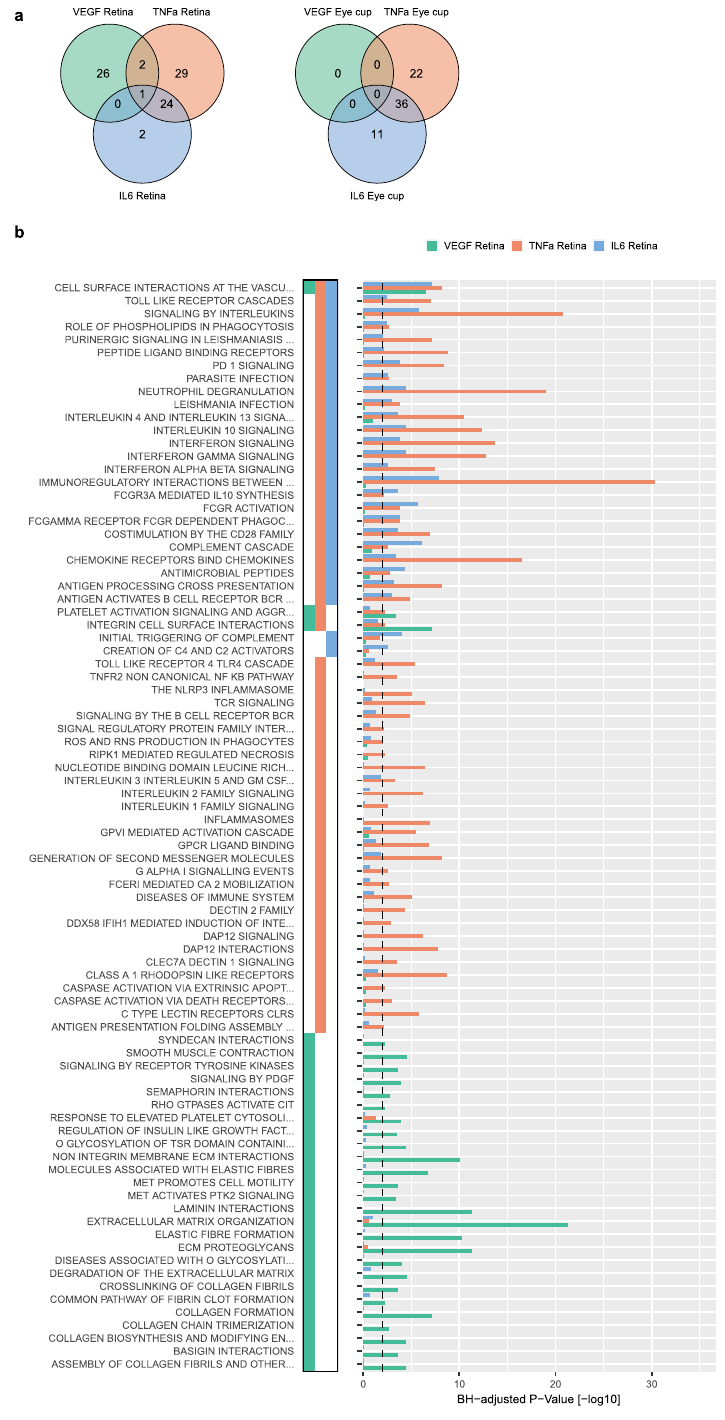
Figure 3. AAV-VEGF treatment altered ECM-related genes, while AAV-TNF-α and AAV-IL-6 induced a strong inflammatory response in retinal tissue. ( a ) 33 pathways were specifically regulated by VEGF in the retina and a majority of pathways regulated by IL-6 was also regulated by TNF-α in both retina and eye cup tissue. ( b ) All REACTOME pathways significantly enriched (BH-adjusted p-value < 0.01) in at least one of the treatments (AAV-VEGF, AAV-TNF-α, and